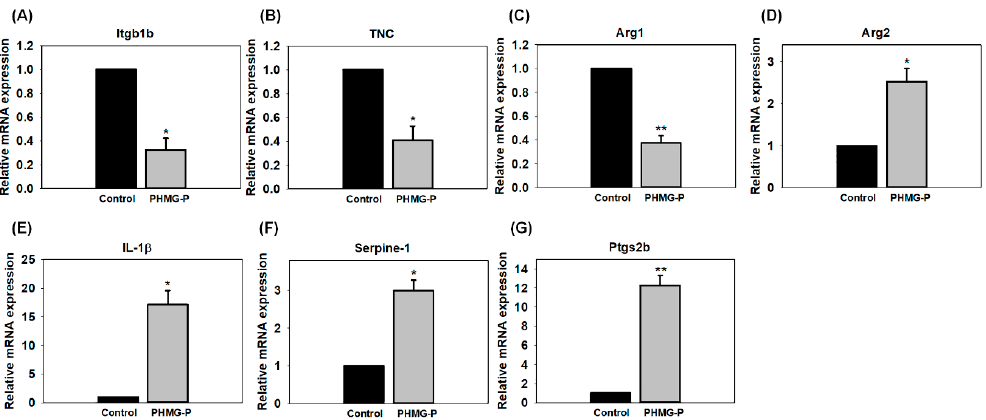
Figure 4. Gene transcription changes of Itgb1b ( A ), TNC ( B ), Arg1 ( C ), Arg2 ( D ), IL-1 β ( E ), Serpine-1 ( F ), and Ptgs2b ( G ) after 96 hpf PHMG-P exposure ( N = 3). Asterisks (* and **) denotes statistical